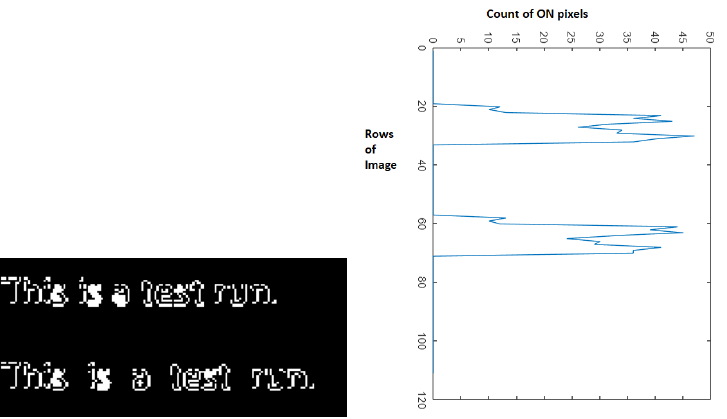
Figure 3. Horizontal histogram Projection and histogram projection of each line.